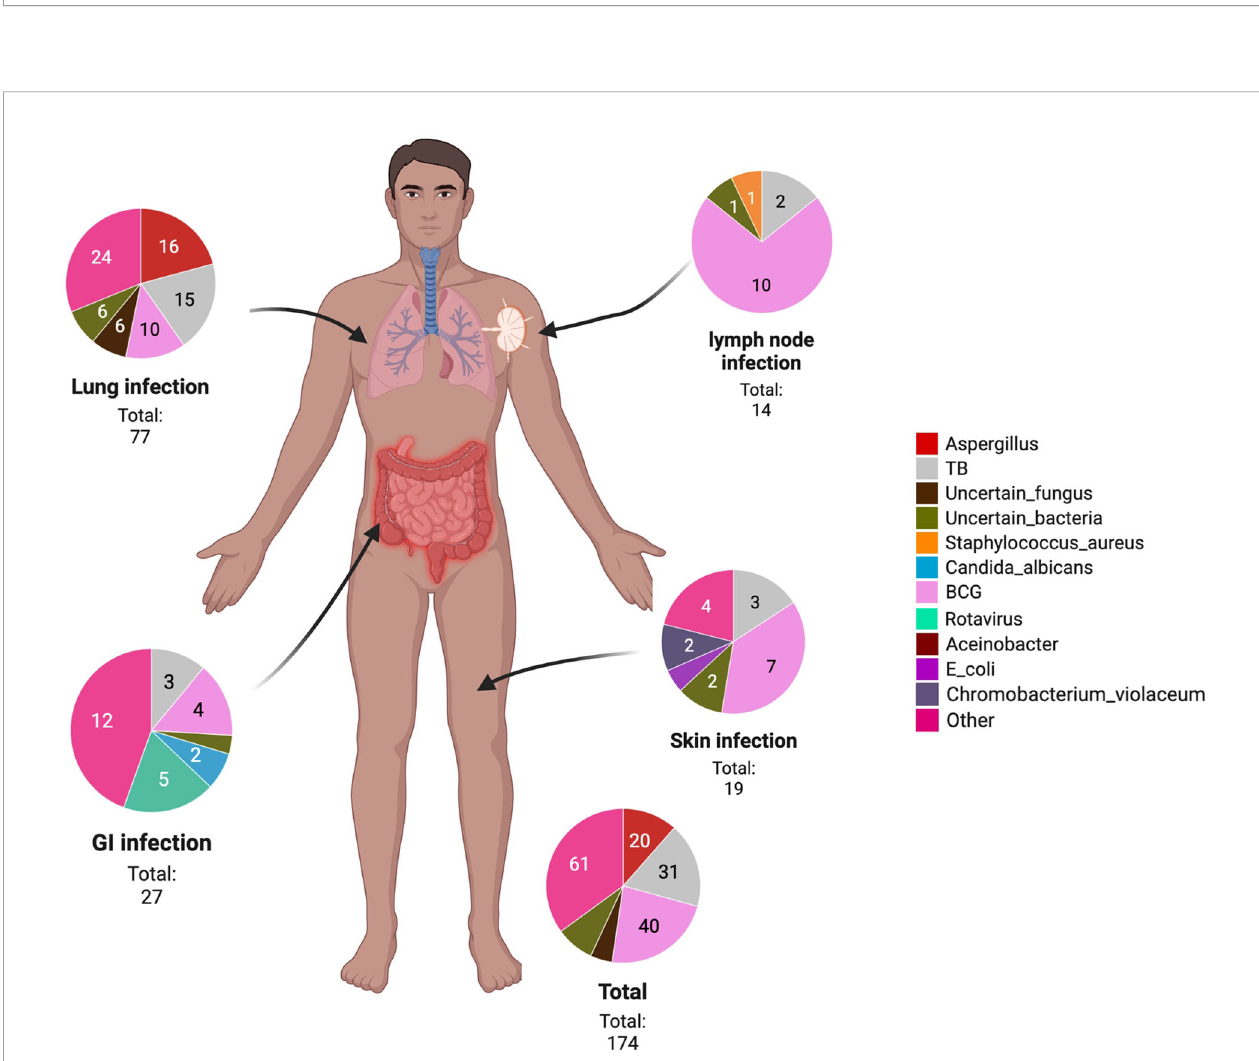
FIGURE 3 | A body map showing the infection location of pathogens in our CGD case series. GI, gastrointestinal; TB, Mycobacterium tuberculosis ; E. coli , Escherichia coli ; BCG, Bacillus Calmette – Gue ́